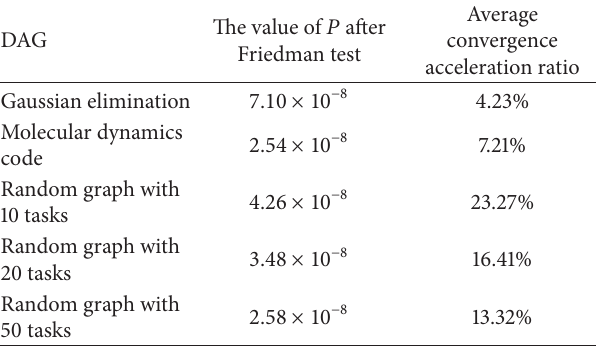
Table 18: The results of the statistical analysis over the average coverage rate at different sampling times of all the experiments (the threshold of P is set as 0.05